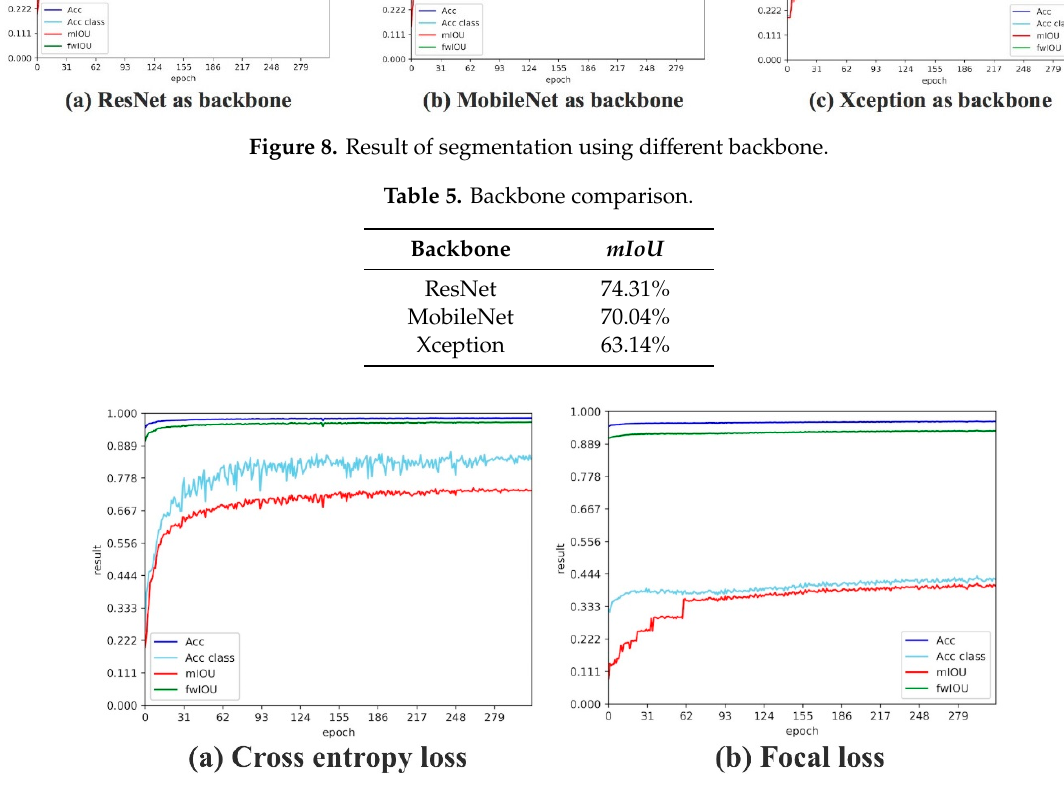
Figure 9. Result of segmentation by different loss function.